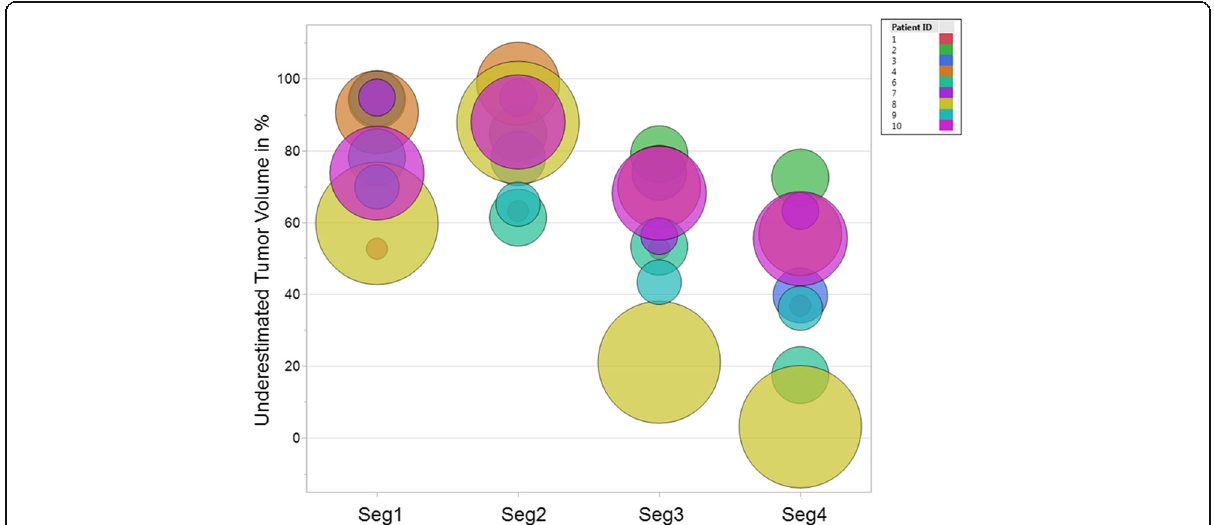
Fig. 4 Bubble plot of underestimated tumor volumes. The percentage underestimation of the true tumor volume as determined by histology is given for the two human readers (seg1, seg2), the gradient-based segmentation method (seg3), and the union of seg1 – 3 (seg4). The diameter of the colored bubbles is proportional to the true tumor volume, and the color reflects the patient ID across segmentations (see Table 1). Please note that the underestimated tumor volume for the patient with the longest time period between imaging and prostatectomy, harboring the only high-risk cancer in this cohort (patient ID 9), is well within the range of the remaining